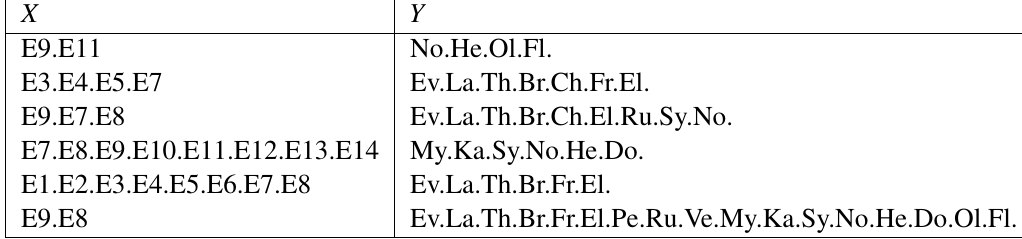
Table 3: θ = 0.6, Final clusters for Southern Women Data Set :